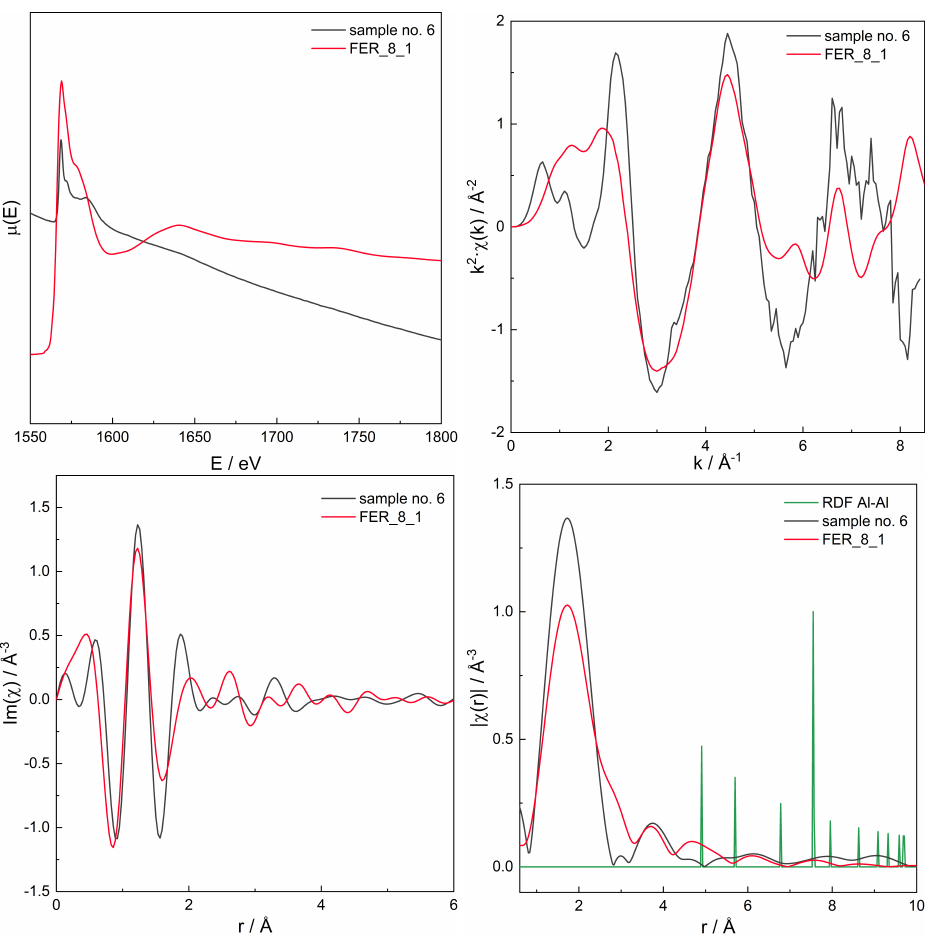
Figure 6. Spectrum of µ ( E ) ( upper left panel ), k 2 χ ( k ) ( upper right ), (cid:61) χ ( r ) ( lower left ), and | χ ( r ) | ( lower right ) for sample no. 6 * (FER of Si/Al = 9), and simulation for computational model labelled FER_8_1, augmented with the Al–Al RDF. Matching RMS = 0.0443. The simulation model characterised by Al–Al distances of: 4.9, 5.7, 7.5, and 9.5 Å. * see Table 2 for sample